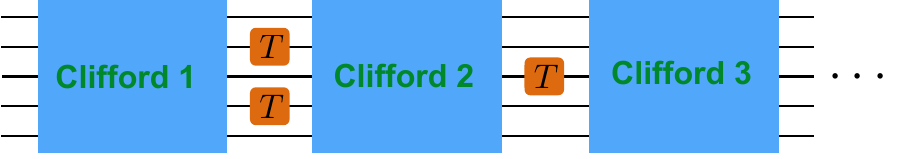
Figure 7: ES statistics of states generated by applying Eq. 7 to random product states. π Left: W-D distribution for θ = (inserting T gates); right: Poisson distribution for 8 θ = π (inserting S gates). The data are obtained for system size N = 12 with n 4 T or S gate inserted, and averaged over 800 realizations of initial states and random Pauli strings.